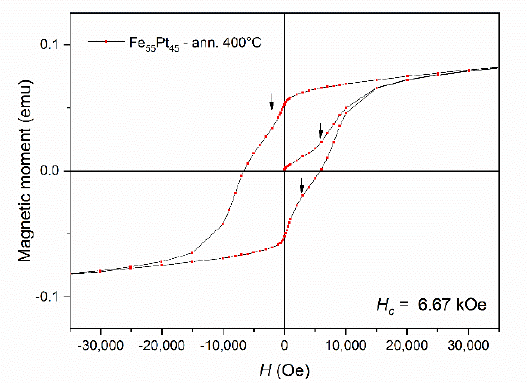
Figure 7. Initial magnetization and hysteresis loop of the sample Fe 55 Pt 45 annealed at 400